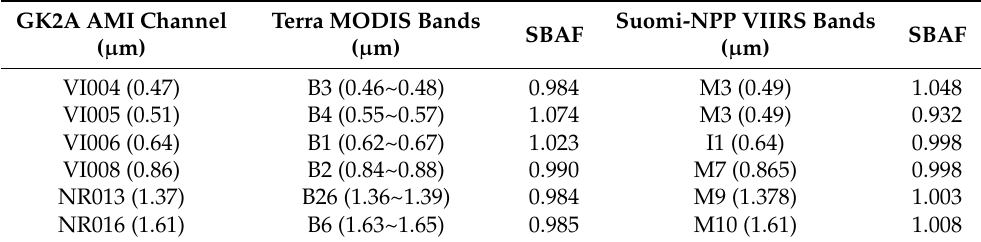
Table 4. Spectral band adjustment factor (SBAF) values and matching channels for ray match- ing